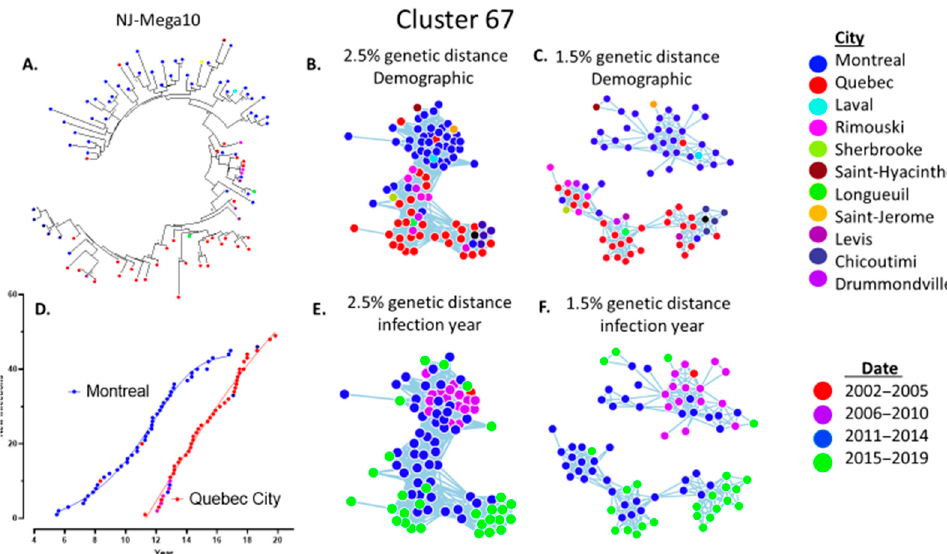
Figure 6. Phylogenetic topologies reveal recurrent waves implicated in the expansion and demographic spread of the cluster 67 sub-epidemic. ( A ) MEGA10 phylogeny of clade 67 reveals an initial wave in Montreal (blue nodes) followed by recurrent waves of spread in Quebec City (red nodes). ( B , C ) MicrobeTrace topology at 2.5% and 1.5% GD reveals demographic spread of clade 67 variants. ( D ) The alphanumerical year (2005–2020) of spread of clade 67 in Montreal and Quebec City outbreaks. ( E , F ) The quadrennial year of diagnosis of cluster 67